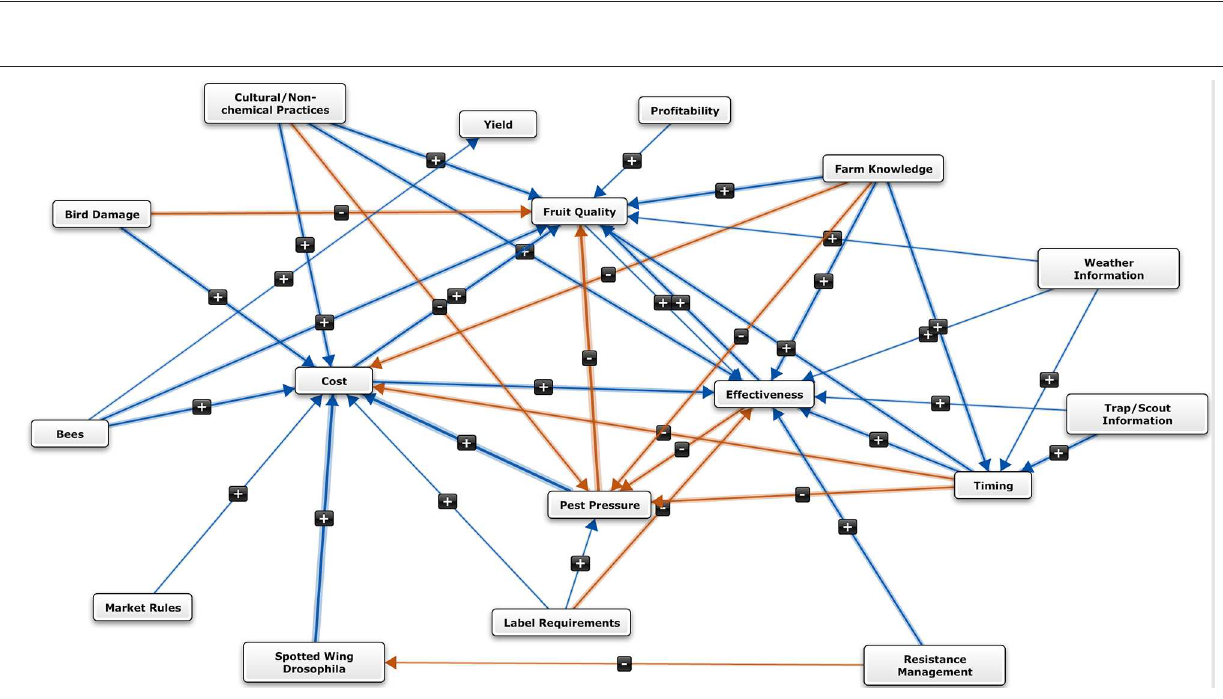
Frontiers in Sustainable Food Systems |